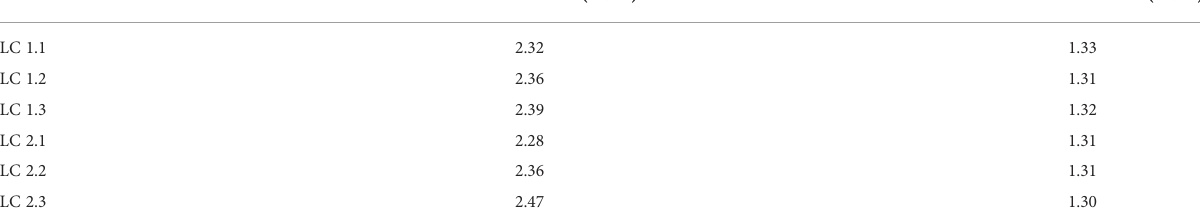
TABLE 6 Comparisons of tower top acceleration statistics. Load